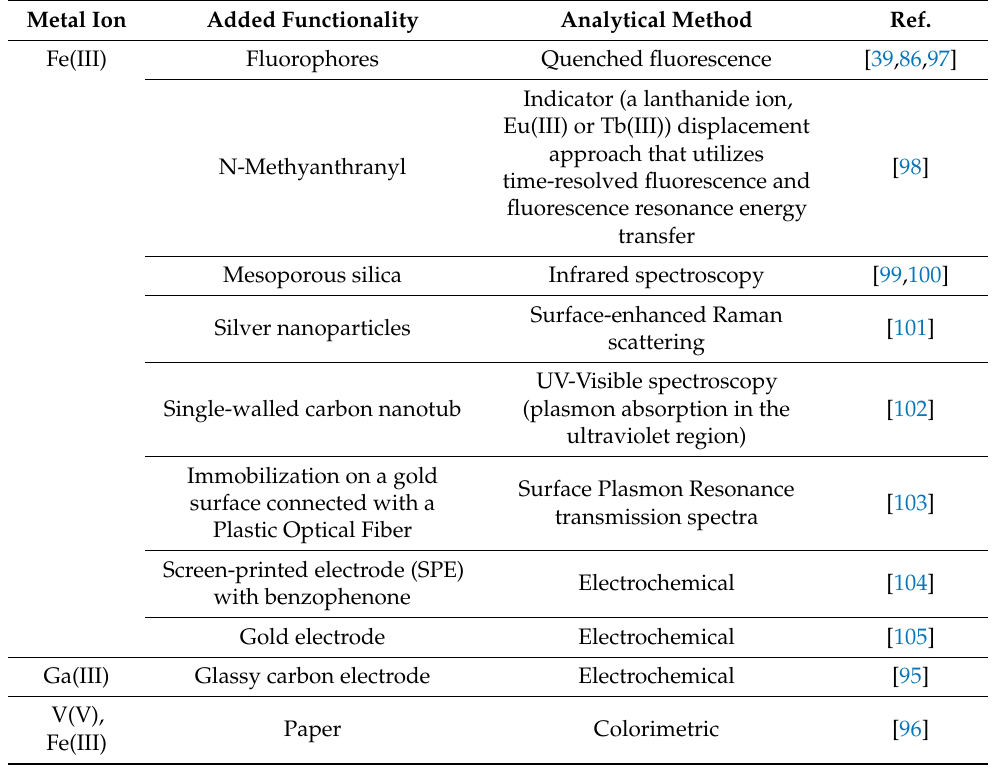
Table 9. Applications and characteristics of DFOB metal